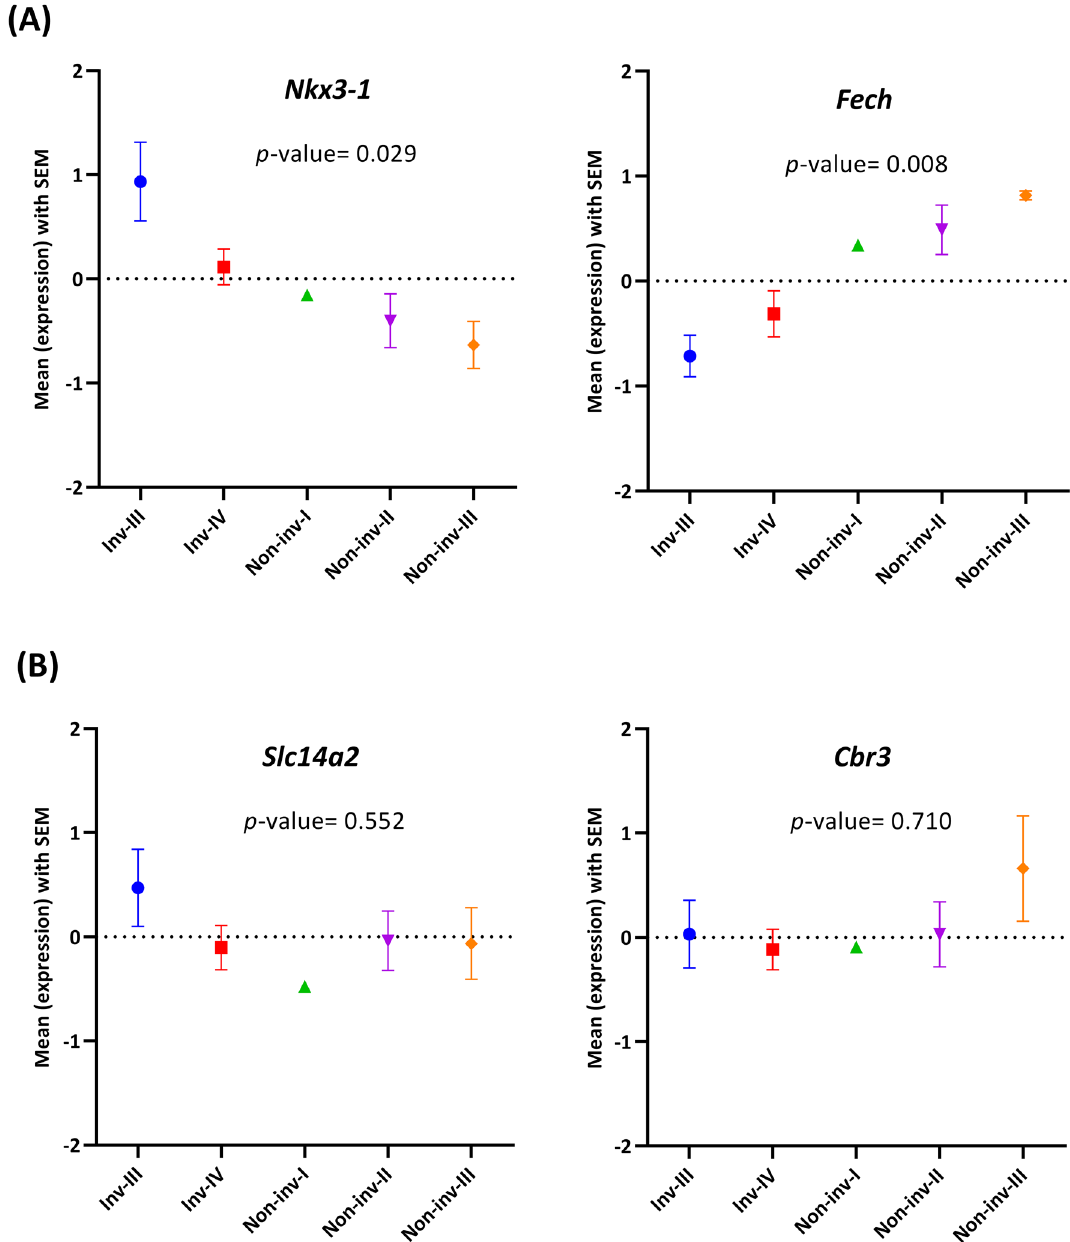
Figure 6. Mean expression level plot in the different grades of invasive and non-invasive pituitary adenomas for ( A ) two identified switch genes (i.e., Nkx3-1 and Fech genes); and ( B ) two exemplary random genes (i.e., Cl14a1 and Cbr3